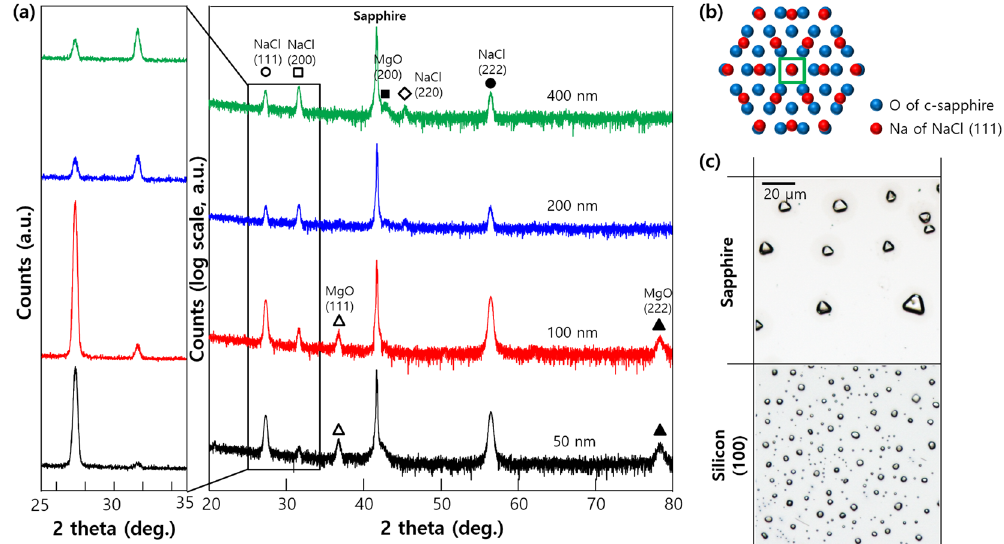
Figure 4. ( a ) XRD patterns of NaCl films grown on c-sapphire substrates at different film thicknesses. ( b ) Schematic of 2/3 domain matched epitaxial growth of NaCl(111) on c-sapphire substrate. ( c ) Optical microscopy images of recrystallized NaCl grains on c-sapphire (top) and Si(100) substrates